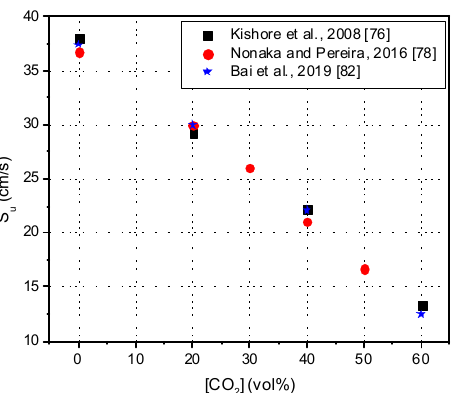
Figure 5. Variation of experimental laminar burning velocities with carbon dioxide content for CH 4 -CO 2 -air mixtures with equivalence ratio of 1.1, at ambient initial conditions. Decreasing of the laminar burning velocity with increase in carbon dioxide content is also observed when examining data from numerical modeling. Figure 6 gives experi- mental and numerical data from Yadav et al. [24] and the calculated data from Boushaki et al. [99].